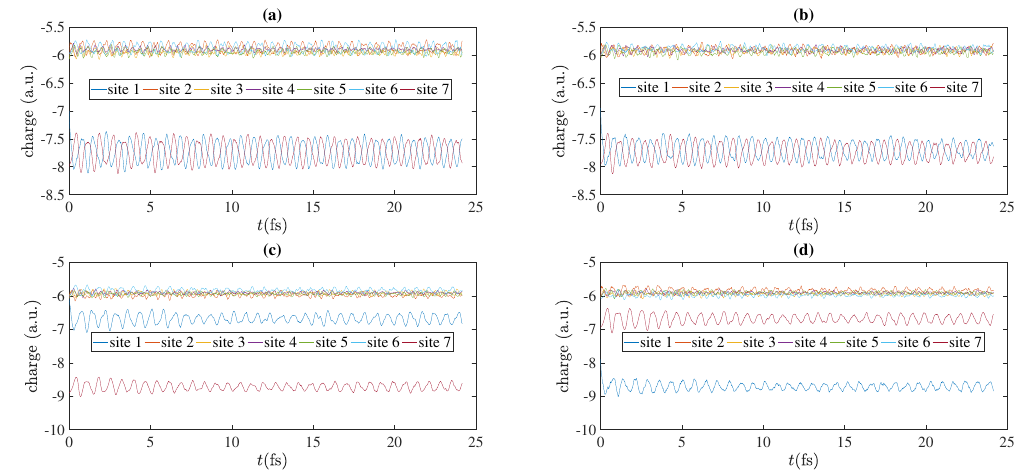
Figure 11. Charge oscillations obtained by RT-TDDFT, at the B3LYP/cc-pVTZ level of theory, N = 7, for cumulenic ( cu ) molecules with coplanar ( co ) and perpendicular ( pe ) methylene groups as well as polyynic ( po ) molecules starting with short ( sl ) or long ( ls ) bonds. ( a ) cu co , ( b ) cu pe , ( c ) po sl , ( d ) po ls .